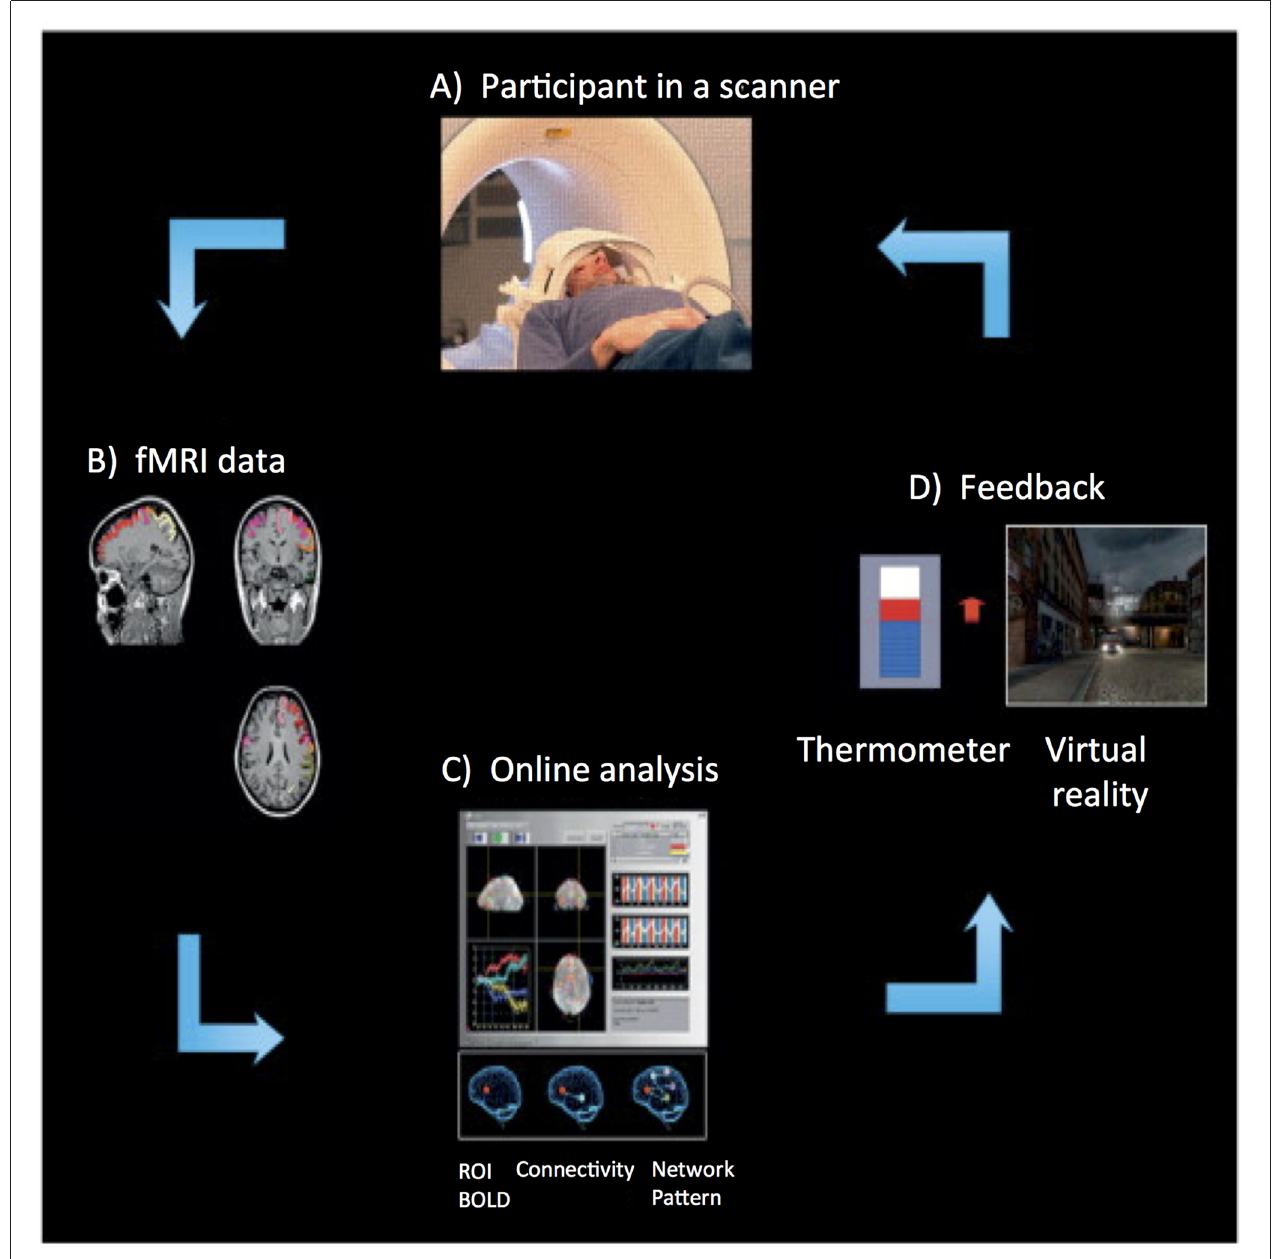
FIGURE 1 | Overview of an real-time functional magnetic resonance imaging (rtfMRI)-based neurofeedback system that comprises the following subsystems. (A) Participant in the MRI scanner. (B) Signal acquisition (fMRI data) using an echo planar imaging (EPI) pulse sequence. (C) Online analysis and computation of the neurofeedback based on the Blood Oxygenation Level Dependent (BOLD) response. (D) Visual feedback via the scanner projection system. This figure is adapted from Birbaumer et al. (2013). The rtfMRI system presented in this figure was developed at the Institute of Medical Psychology and